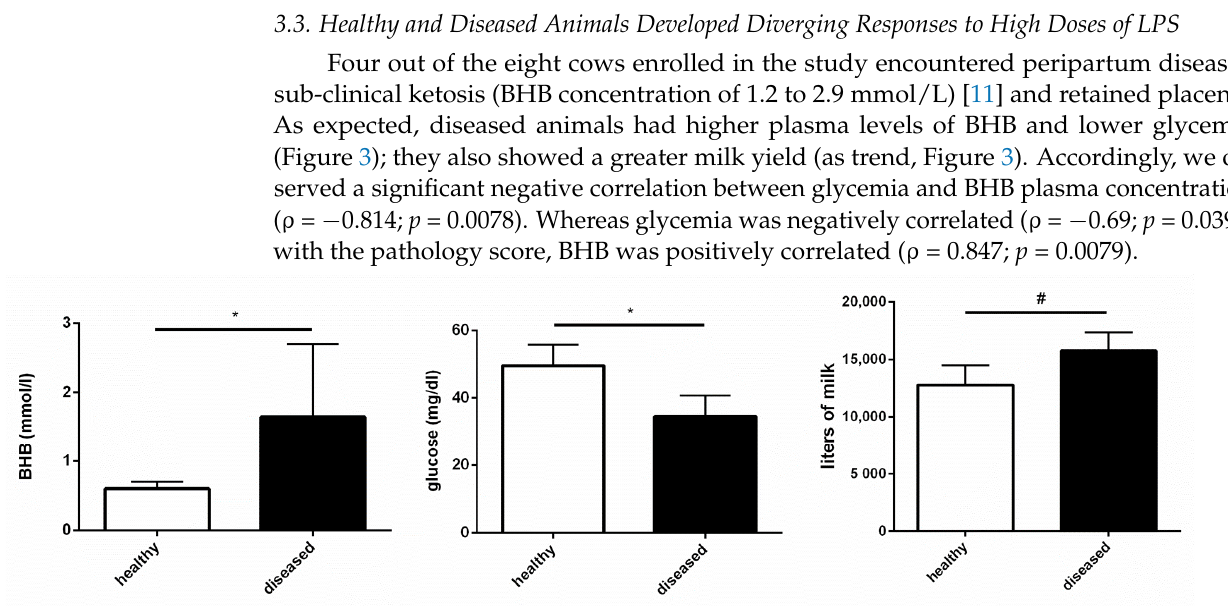
Figure 2. Bovine PBMC gene expression of proinflammatory cytokines and kynurenine molecules at different time points. Bovine PBMCs isolated at 3 different time points (T0 = 15 days before calving; T1 = 7 days post-calving, T2 = 21 days post-calving) were in vitro stimulated with LPS (20 mg/mL) or kept untreated. Gene expression was determined by RT qPCR assay. # p < 0.1, * p < 0.05.